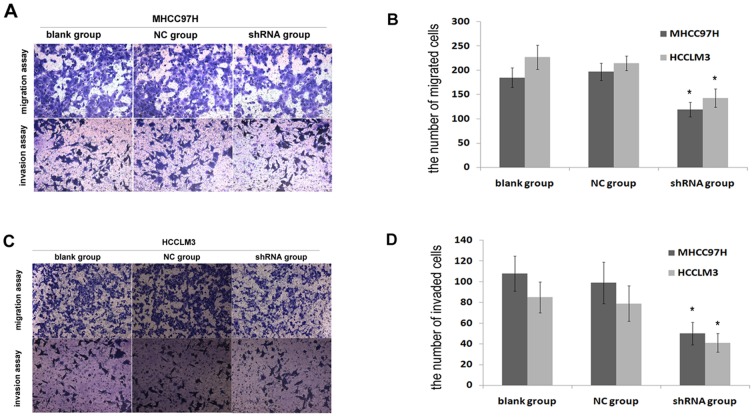
Nodal suppressed migration and invasion of HCC cells in vitro.(A, B) Effect of Nodal knockdown on MHCC97H cell migration and invasion in vitro. (C, D) Effect of Nodal knockdown on HCCLM3cell migration and invasion in vitro. Data are Mean ± SD of three replicates. * P<0.05.